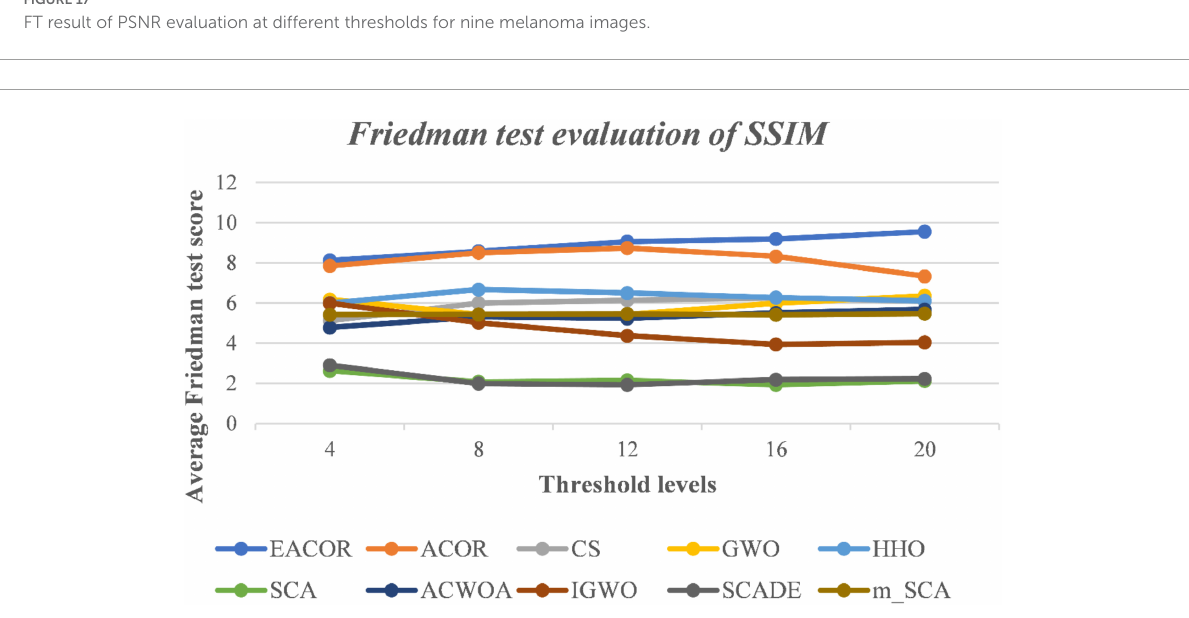
FIGURE18 FT result of SSIM evaluation at different thresholds for nine melanoma